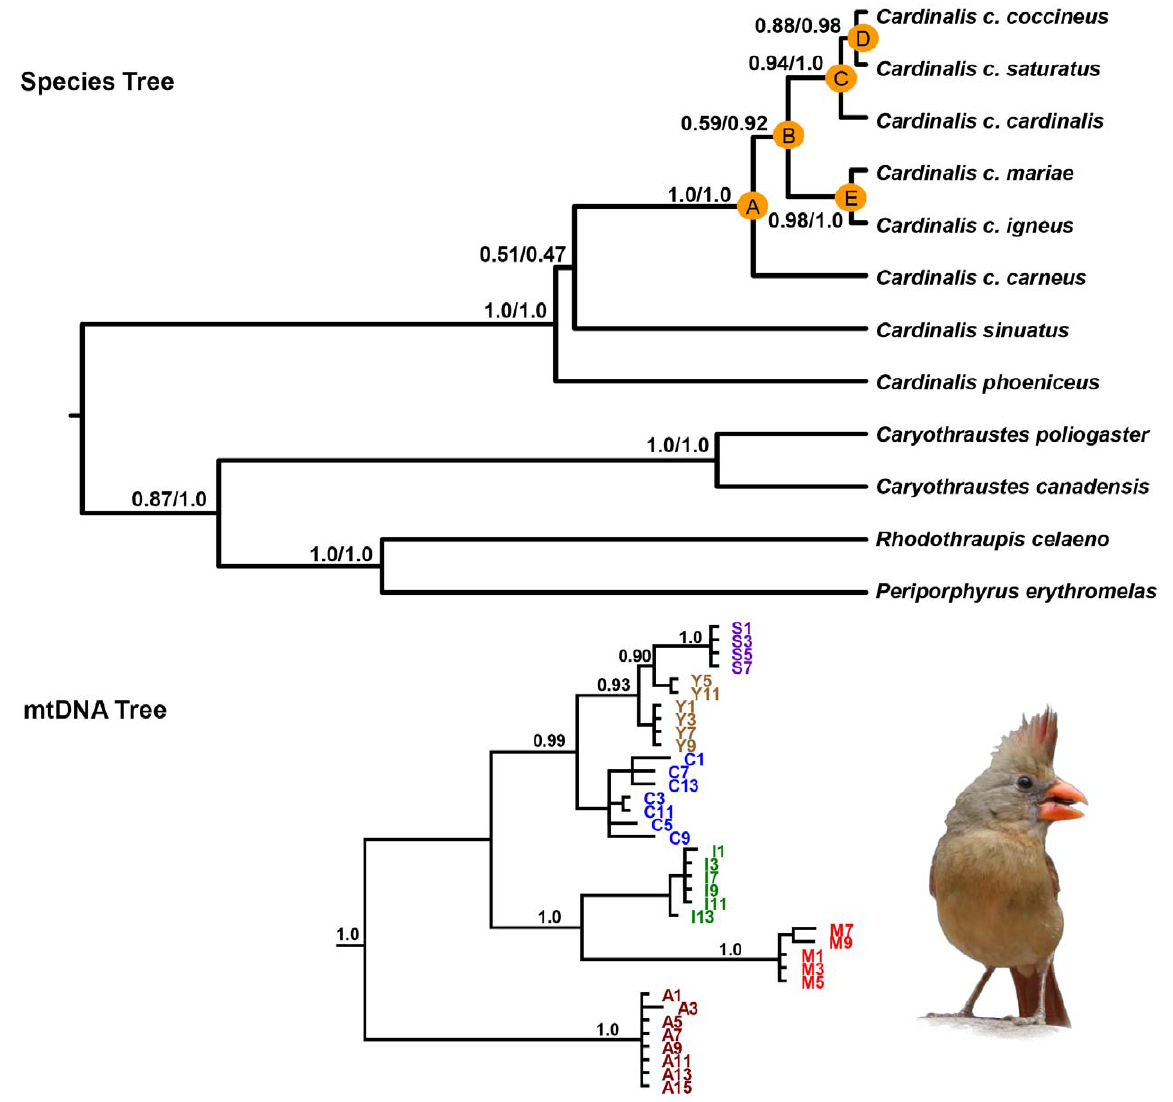
Figure 2. Multilocus species tree and mtDNA tree for Cardinaliscardinalis and allies. Species tree estimated from *BEAST using nuclear only data set, and nuclear and mtDNA combined data set (top). Posterior probabilities (PP) are reported for each node (left PP – nuclear DNA only species tree; right PP –mtDNA and nuclear DNA species tree) and the nuclear and mtDNA combined data set tree is shown. Letters on the species tree correspond to divergences among C. cardinalis lineages: A) carneus – all other lineages; B) igneus / mariae – cardinalis / coccineus / saturatus ; C) cardinalis – coccineus / saturatus ; D) coccineus – saturatus ; E) i gneus – mariae . Nodes D and E refer to the island-mainland divergences. Shown on the bottom is the Bayesian mtDNA (ND2) tree of C. cardinalis lineages with PP plotted on nodes: S – saturatus (purple); Y – coccineus (brown); C – cardinalis (blue); I - igneus (green); M - mariae (red); A – carneus (maroon). An image of a female C. cardinalis igneus is shown. doi:10.1371/journal.pone.0055161.g002 PLOS ONE |